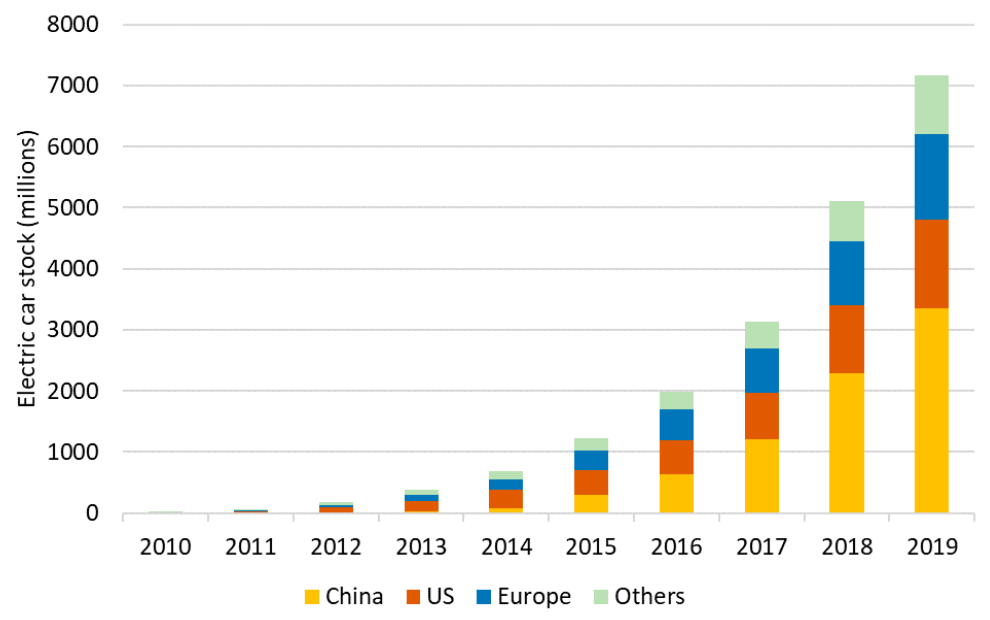
Figure 8. The global stock of rechargeable EVs, 2010–2019 (Data source: [47]). However, based on the share of EVs in the total vehicle stock, Norway is the worldwide leader. For example, the electric car market share in Norway was 56% in 2019, followed by The Netherlands (15%) and Sweden (12%). In most other countries, the electric car market share is well below 5%